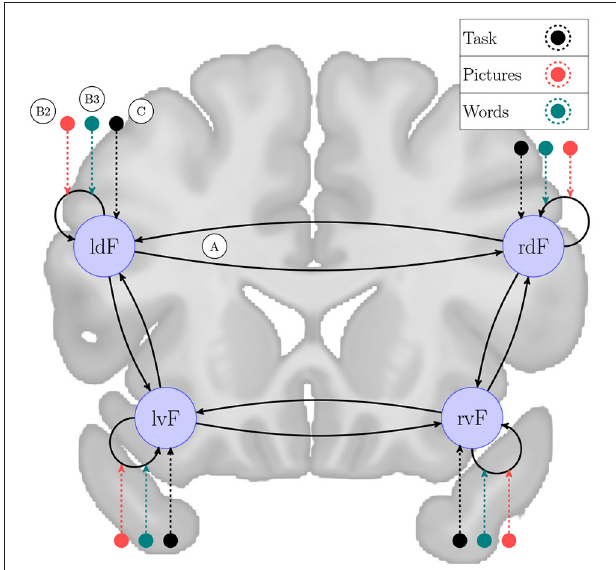
FIGURE 1 | Network scheme for semantic decision task. A DCM model example to explain brain functions during semantic processing of words and pictures, originally investigated by /Seghier 2011/. The experiment consists of four frontal brain regions: left ventral (lvF), left dorsal (ldF), right ventral (rvF) and right dorsal (rdF). This network is examined in a task designed to involve three conditions: “Pictures” and “Words” includes onsets for the corresponding semantic decision trials and “Task” includes all trials. We generated a model-space of 65,536 models with every possible combination of endogenous connectivity matrix A, along with their experimental modulation, denoted by B1, B2, and B3. We fixed the direct effects, described by matrix C, to “Task” driving each region as experimental input. On the figure the network nodes are overlain on a coronal section of the brain captured from the average brain template of the Montreal Neurological Institute (Grabner et al.,